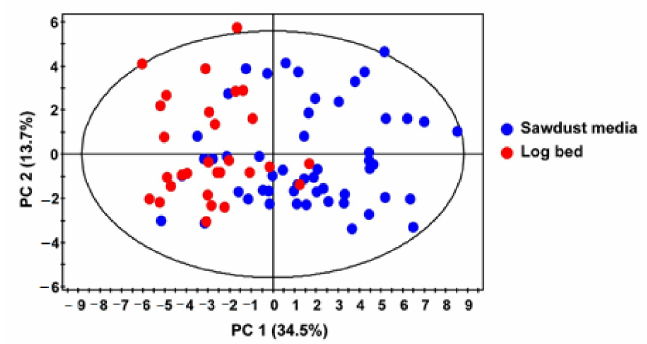
Figure 2. PCA score plot of quantified metabolites from 1 H NMR analysis in L. edodes